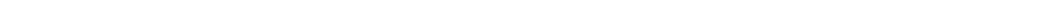
(see fi gure on previous page) Fig. 2 Effect of MLL5 on proliferation assays. A Growth curves, B Ki67 staining and C cell cycle analysis of NB4 and NB4-R2 cell lines lentivirally transduced with MLL5 or empty vector (pMEG, control). D Representative example of one of four independent experiments of colony formation assay in methylcellulose using lentivirally transduced NB4 and NB4-R2 cell lines. Graphic bars represent the number of colony-forming cells in each well. E Graphic bars represent the number of colony-forming cells in each well in NB4 cells transduced with MLL5 or empty vector (pMEG, control) treated with vehicle (DMSO, control) and ATRA (0.1 and 0.5 µM). Effect of MLL5 on drug-induced apoptosis assay. F Percentage of apoptotic cells after 24, 48 and 72 h in culture with apoptotic stimulus (ATRA 1 µM; ATO 1 µM and AraC 10 nM). G Mitochondrial reactive oxygen species (mtROS, MitoSOX ™ 5 µM) measured by FACS in lentivirally transduced cell lines after 12 h of treatment with ATO (1 µM). All experiments were performed in triplicate. Effect of MLL5 on myeloid differentiation. H Percentage of CD11b + , CD11c + , CD15 + and CD16 + in NB4 cells infected with empty vector or pMEG- MLL5 lentiviruses after 48 (left panel) and 72 (right panel) h of ATRA (1 μ M) alone or in combination with ATO (1 µM each) treatment used as the standard stimulus for differentiation. Effect of MLL5 knockdown on myeloid differentiation. I Western blot for H3K4me3, CDKN1A (p21) of total protein lysates from NB4 cell line infected with empty vector or pMEG- MLL5 lentiviruses and treated with ATRA 1 µM. A total of 30 µg of protein was loaded in each lane. J Gene expression analysis of SETD7 , SETD9 and LSD1 in NB4 cell line infected with shRNAs targeting MLL5 ( shMLL5 ) and scrambled controls (shCTRL) upon ATRA treatment (1 µM). The expression of SETD7 , SETD9 and LSD1 genes was quanti fi ed by Real-time quantitative PCR (RQ- PCR) using GAPDH and ACTB as endogenous control. Note: Data from continuous variable were all expressed as mean ± standard error of the mean. * P < 0.05. *** P < 0.001. NS indicates not signi fi